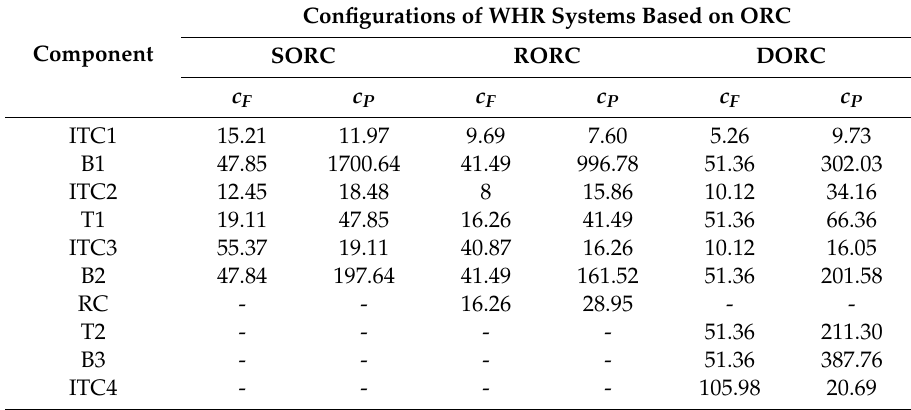
Table 6. Destruction exergy costs and exergy loss costs ( Component